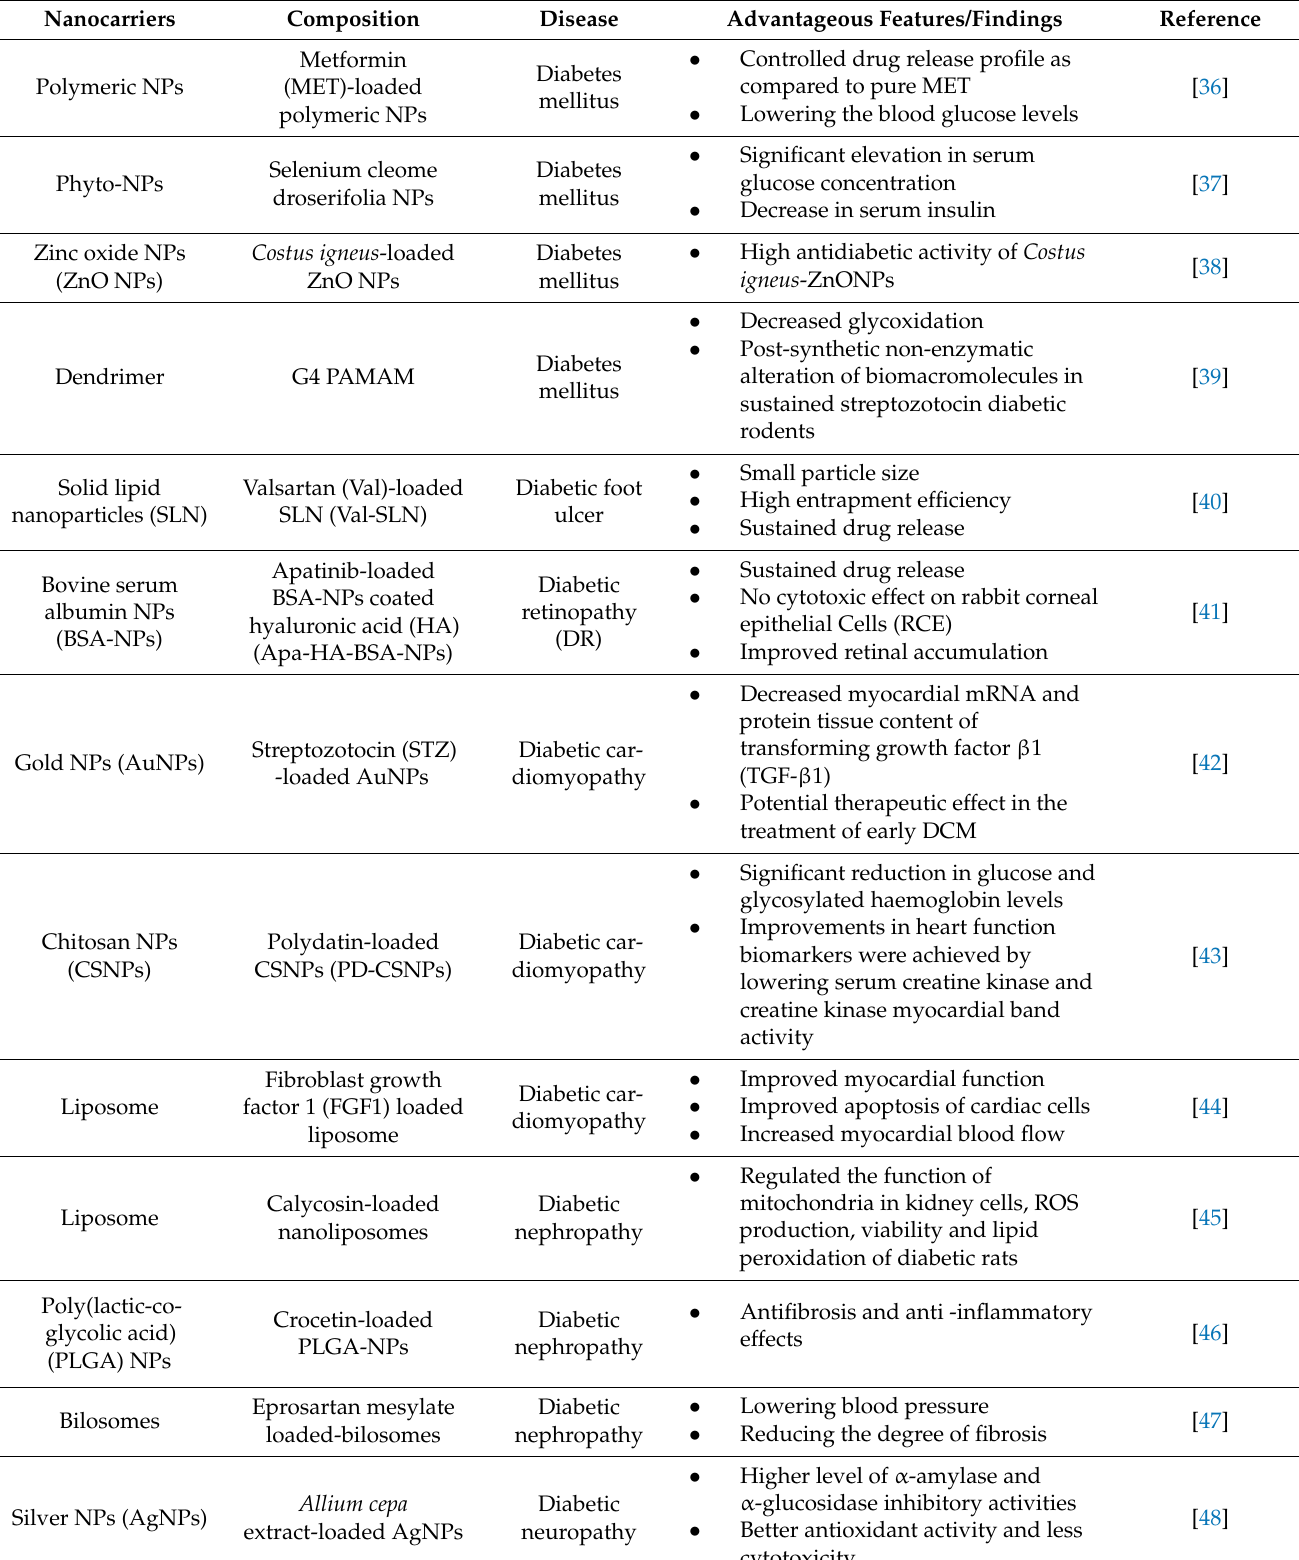
Table 1. Nanocarriers-based therapy of diabetes and associated